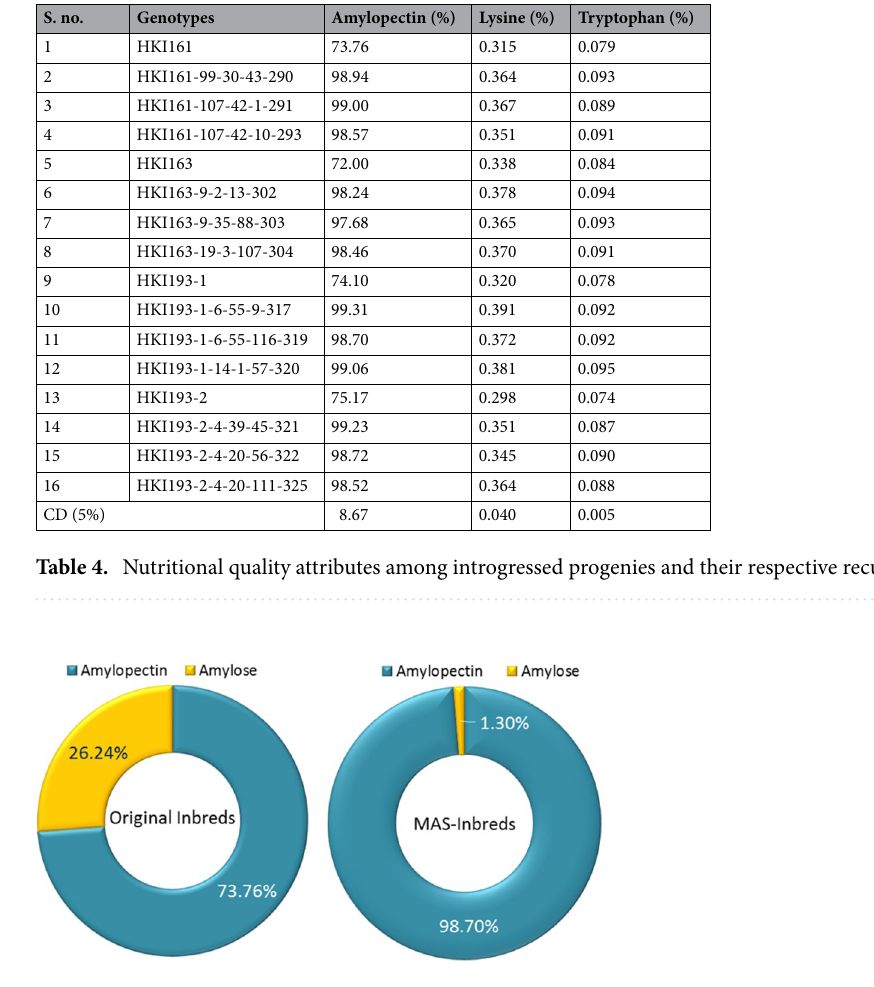
Figure 4. Average amylopectin and amylose content in original and MAS-derived